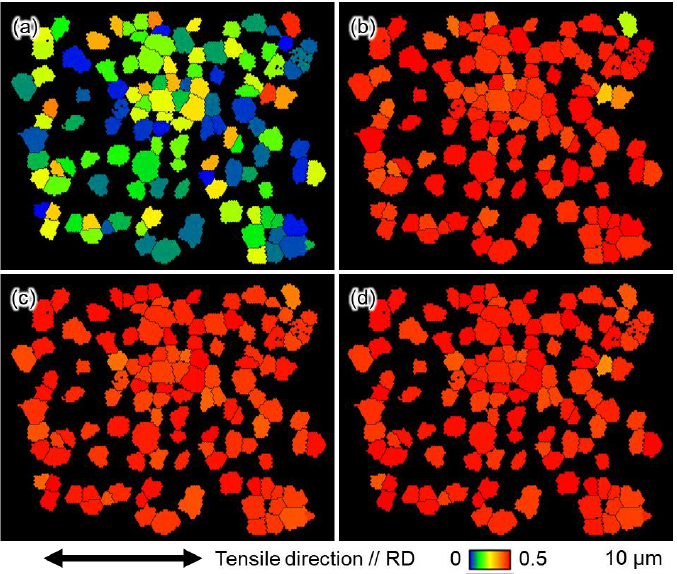
Figure 12. Number of observed slip traces based on Figures 10 and 11 in ( a ) Ti-30 and ( b ) Ti-5 deformed at high (10 0 s − 1 ) and low (10 − 6 s − 1 ) strain rates.